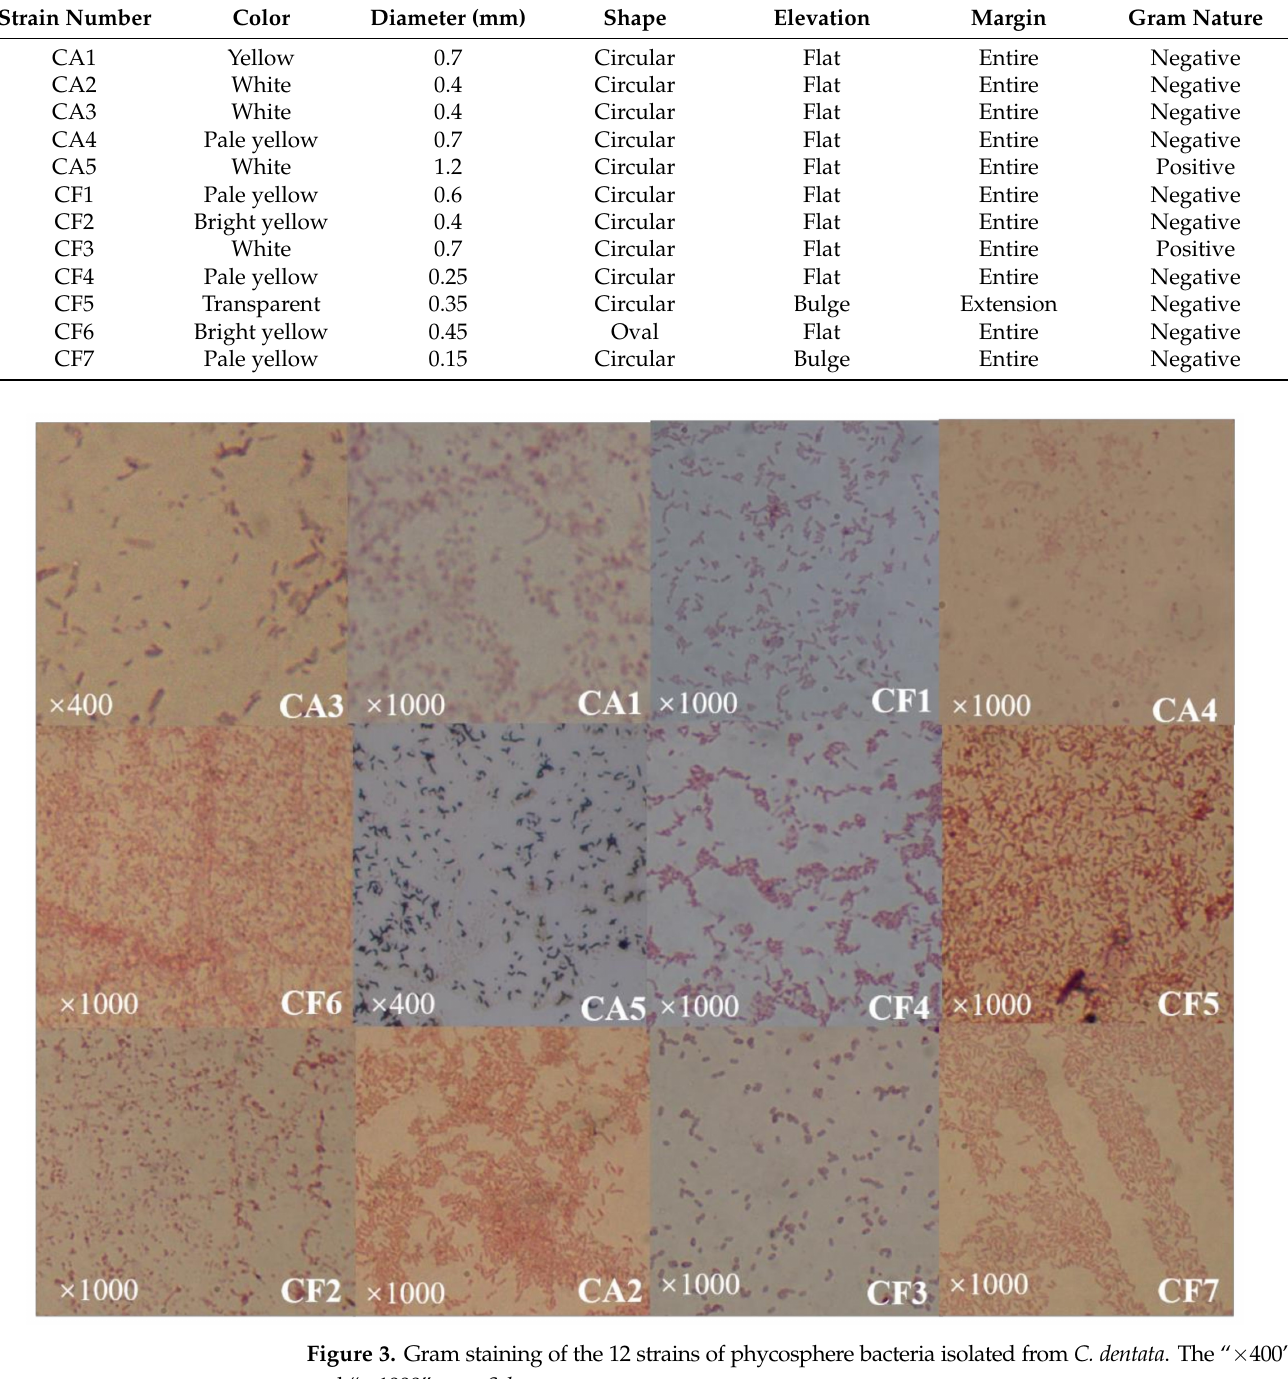
Figure 3. Gram staining of the 12 strains of phycosphere bacteria isolated from C. dentata . The “ × 400” and “ × 1000” repre Scheme